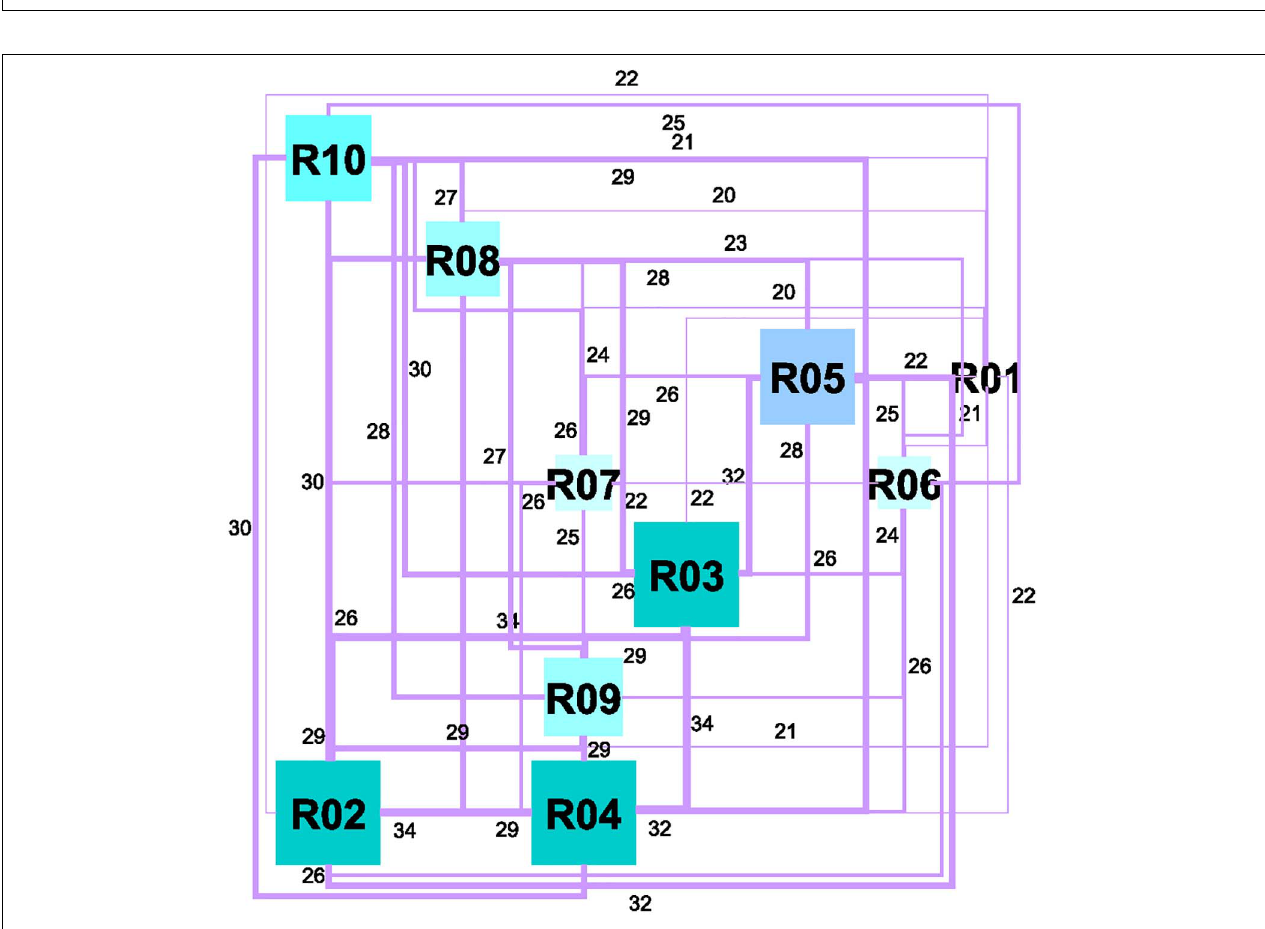
FIGURE 4 | Interlinkages between regional policies. Each box represents a policy indicated by its label. Two policies are linked if they both address the same N themes (N being the weight indicated on the links); links with higher weights are thicker, and lines with weights < 20 are not labelled. Box size is related to the sum of the weights of its